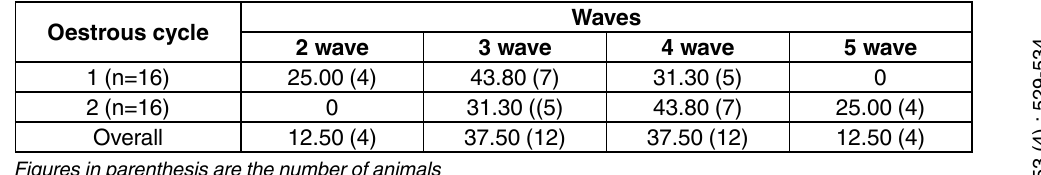
table 2 . Mean interwave interval (days) in three, four and five wave cycles